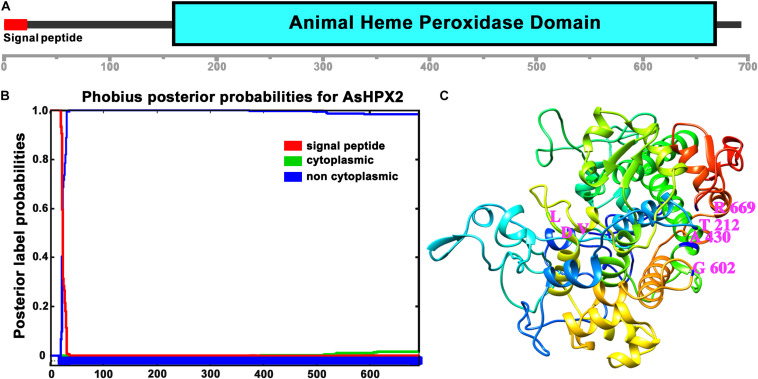
Domain organization of AsHPX2 protein. (A) The amino acid sequence of AsHPX2 protein was analyzed with the help of SMART program that revealed the presence of an animal heme peroxidase domain and N-terminal signal peptide. (B) The AsHPX2 protein sequence was analyzed using Phobius software that also revealed the presence of a signal peptide. (C) Three-dimensional structure of AsHPX2 protein was constructed by TASSER program that depicted the amino acids at active site (represented by letter symbols and numbers indicate their position). The integrin binding motif, LDV is oriented toward the surface of AsHPX2 protein.